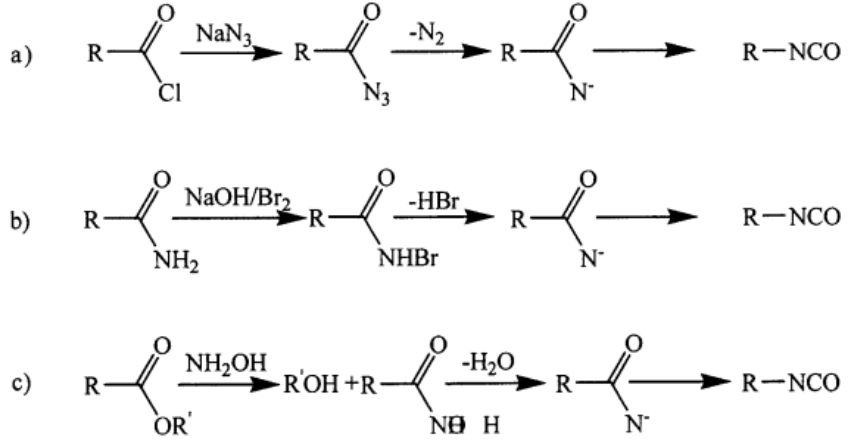
Figure 2. Laboratory-scale synthesis of isocyanates: ( a ) Curtius, ( b ) Hoffman, and ( c ) Lossen rearrangements. From reference [24].